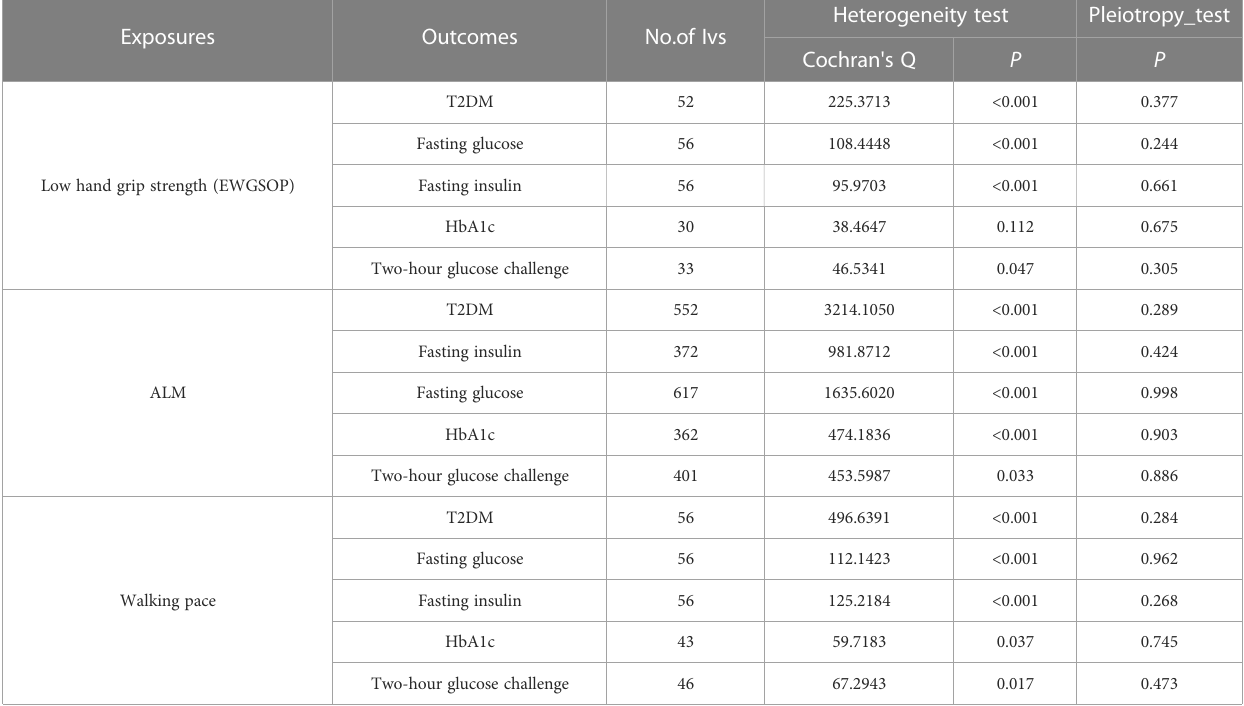
TABLE 2 Association sarcopenia-related traits with T2DM and glycaemic traits using heterogeneity test and pleiotropy test.